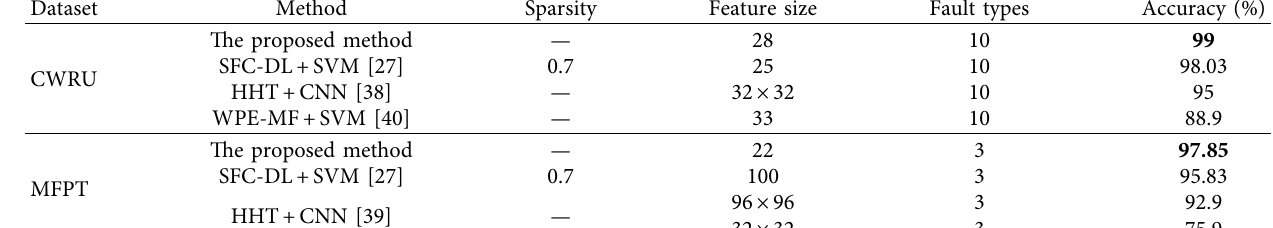
Table 6: Comparison of the proposed method with other methods.